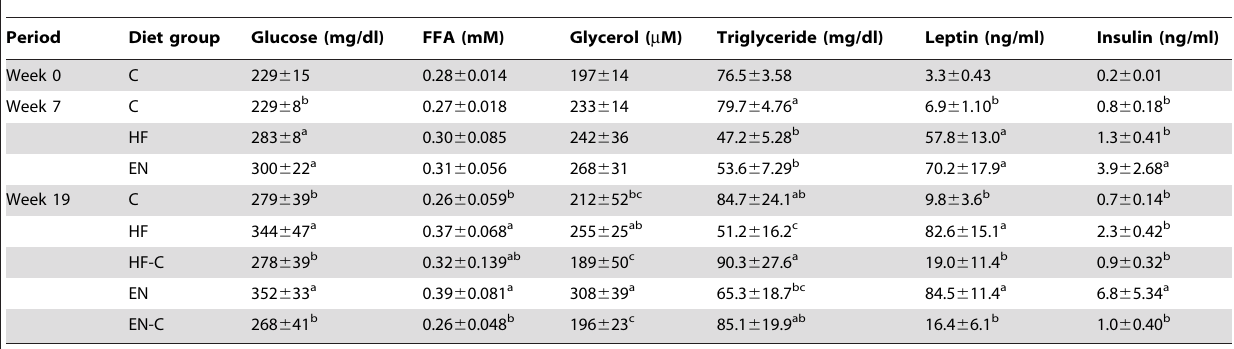
Table 3. Serum glucose, NEFA, glycerol, triglycerides, leptin, insulin concentrations.